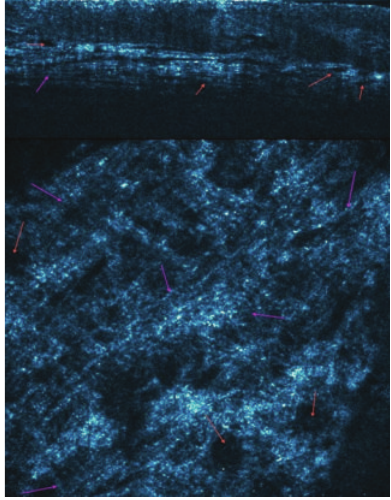
Figure 11: High-Definition Optical Coherence Tomography “slice” view and “en-face” image correlating findings at the level of the lamina propia. Purple arrows: collagen fibers, Red arrows: blood